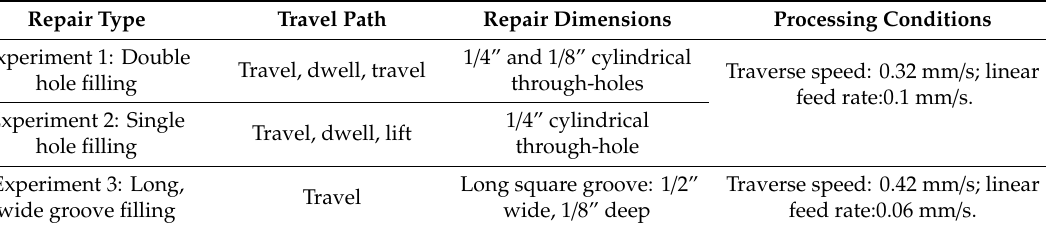
Table 1. Summary of the experimental details.